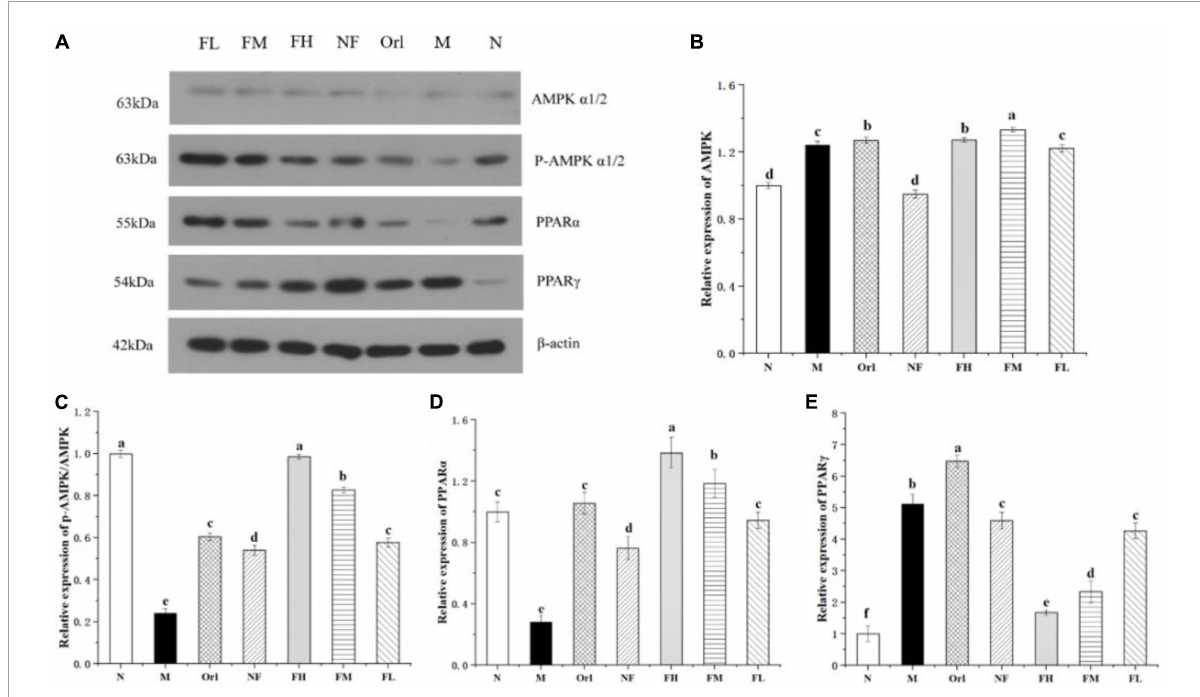
FIGURE4 Effects of FAK on the epididymal adipose tissue in mice. (A) Bands of WB assay. (B–E) Relative protein expression of corresponding genes. All data are expressed as mean ± SD ( n = 5). (a–d) Bands with different letters indicate significant differences ( P <